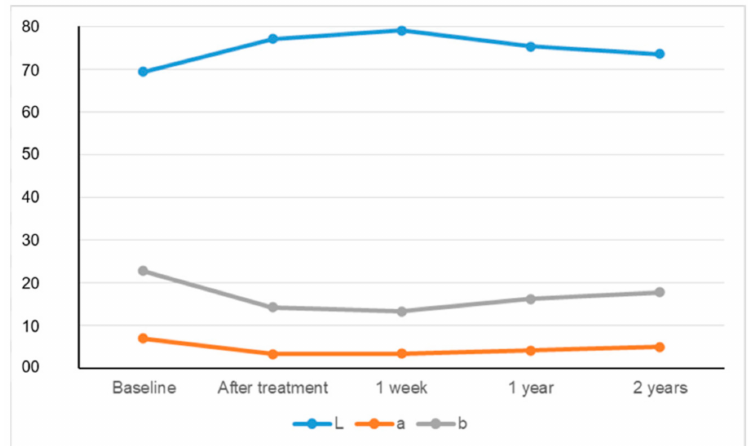
Figure 4. The change of CIEL*a*b* values measured by digital photographs and software over time. *Y-axis defines the numeric values of the parameters L, a, and